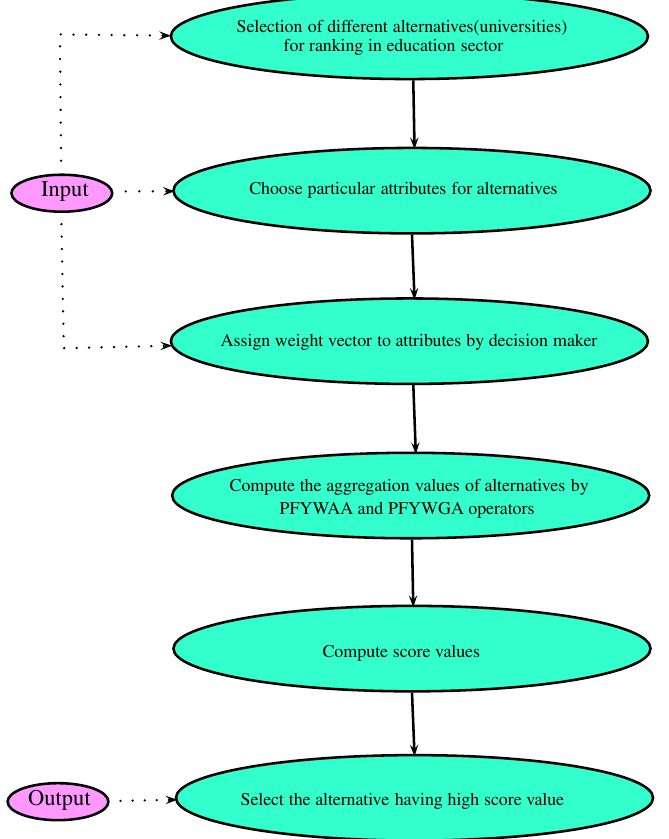
Figure 2. Flow chart to select the high rank university in education